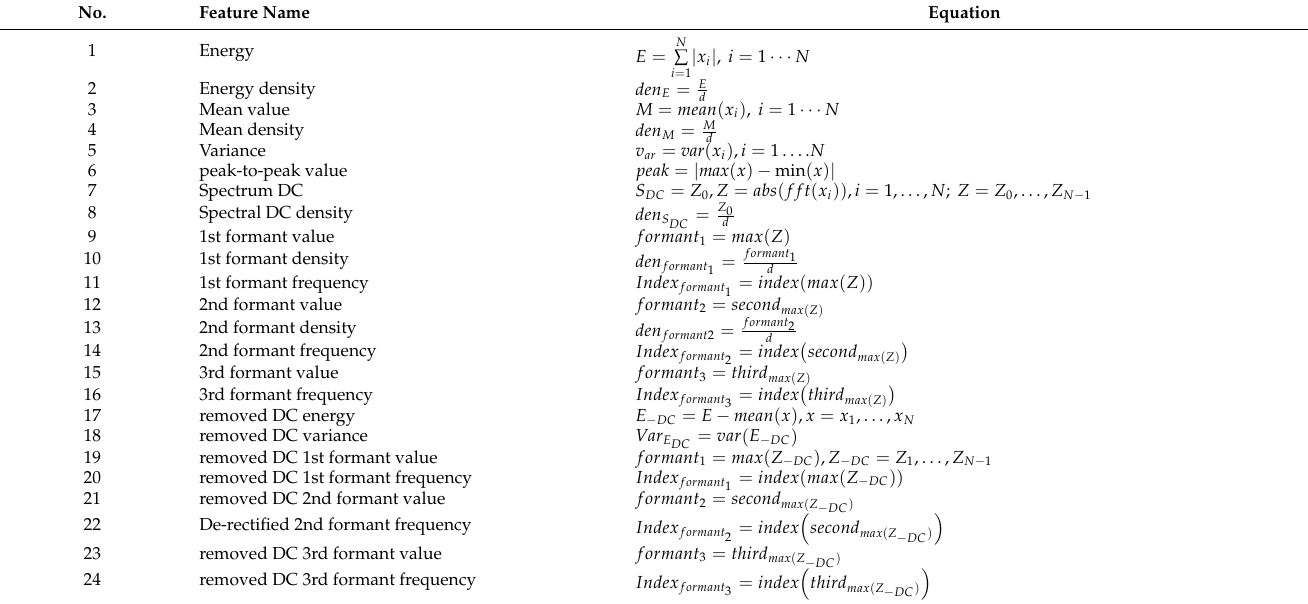
Table 1. Equations of the extracted